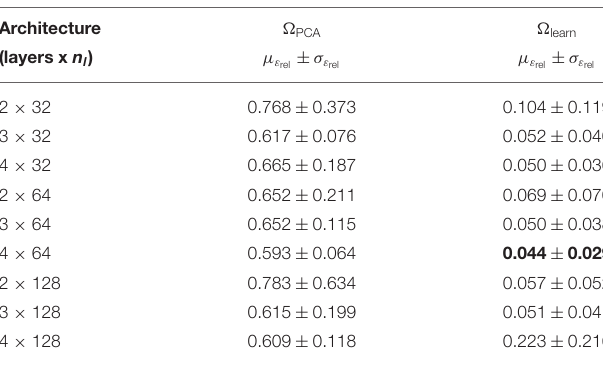
TABLE 2 | Prediction error for the surrogate model trained in the reference domain (cid:127) PCA and learning domain (cid:127) learn .